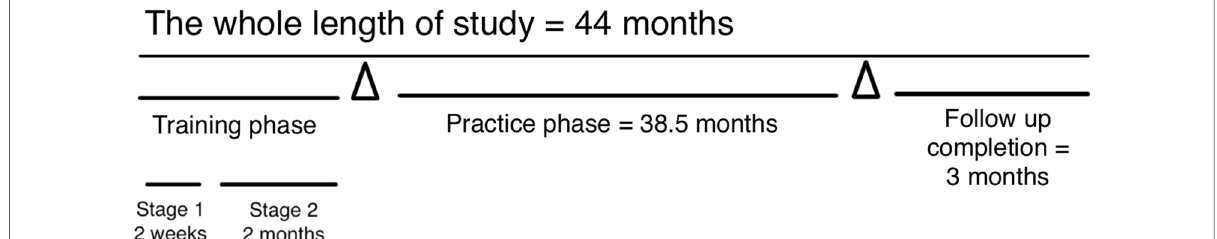
Fig. 1 The timeline of the whole study including; a 2 weeks of academic orientation about the indications, technique, complications and outcome of VATS via literature review and watching illustrated relevant videos for VATS, b 2 months of surgical assistance for anatomical and setup orientation, c 38.5 months of practicing 100 VATS procedures under strict supervision and d 3 months for follow completion of last operated cases